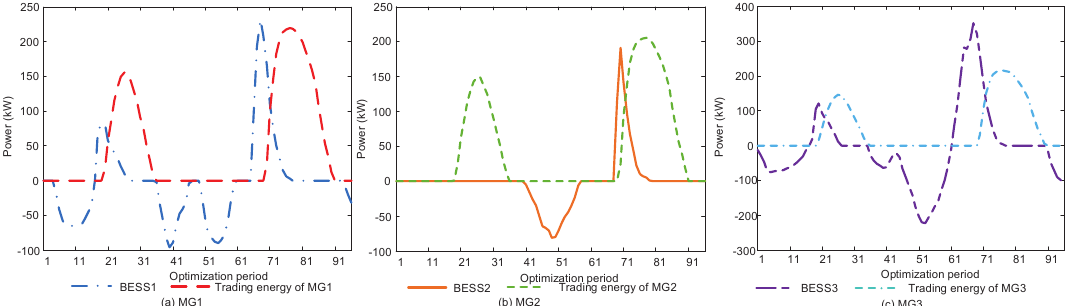
Figure 7. Scheduling results of BESS and purchasing power based on alternating direction method of multipliers (ADMM) on Day 1 of Scenario 1 (( a ) MG1; ( b ) MG2; ( c ) MG3).